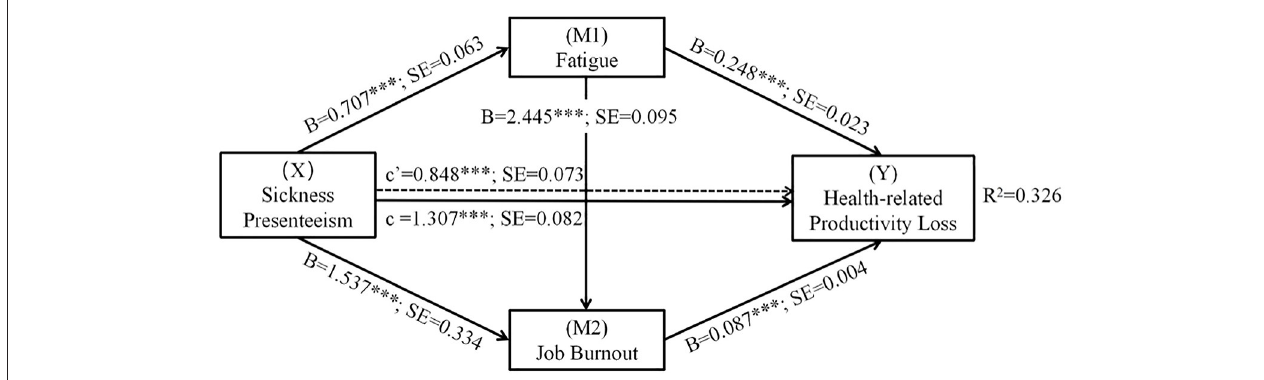
FIGURE 1 | Serial-multiple mediating effect of fatigue and job burnout on the correlation between sickness presenteeism and health-related productivity loss. SE, standard error. B refers to the unstandardized path coefficients; X refers to the independent variable; M1 and M2 refer to mediating variables; Y refers to the dependent variable; Covariates include age, gender, marital status, education, professional title, employment type, department, position, and monthly income. ***p < 0.001.